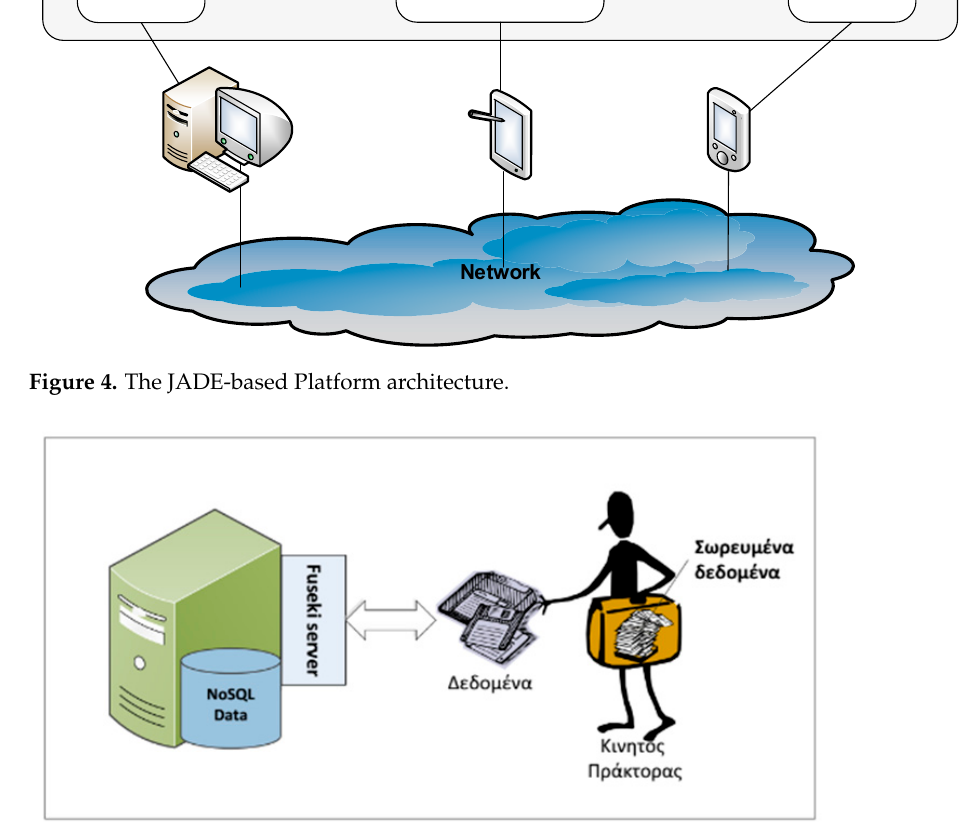
Figure 5. Mobile agent (MA) and Fuseki server interaction.